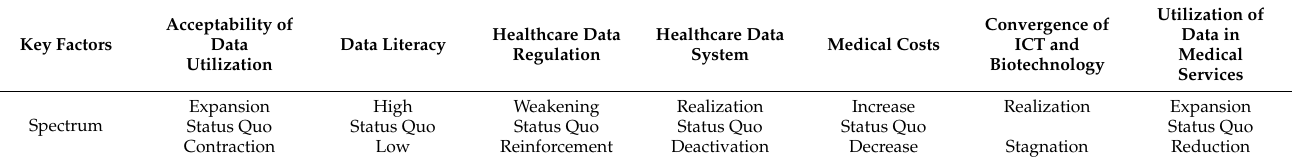
Table 1. Key factors in the future of data-based healthcare economy and